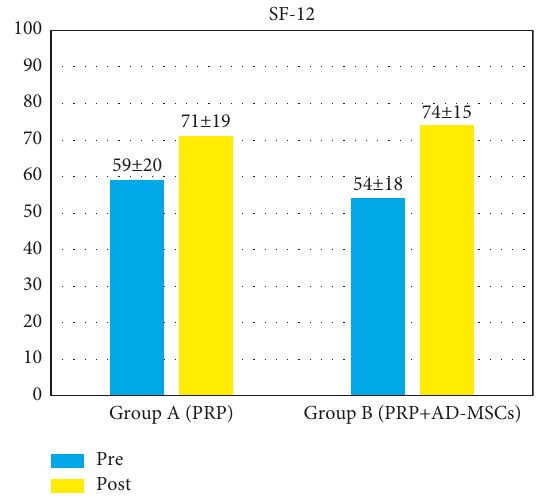
Figure 6: SF-12 (Short-Form 12) score: pretreatment and at 12- months